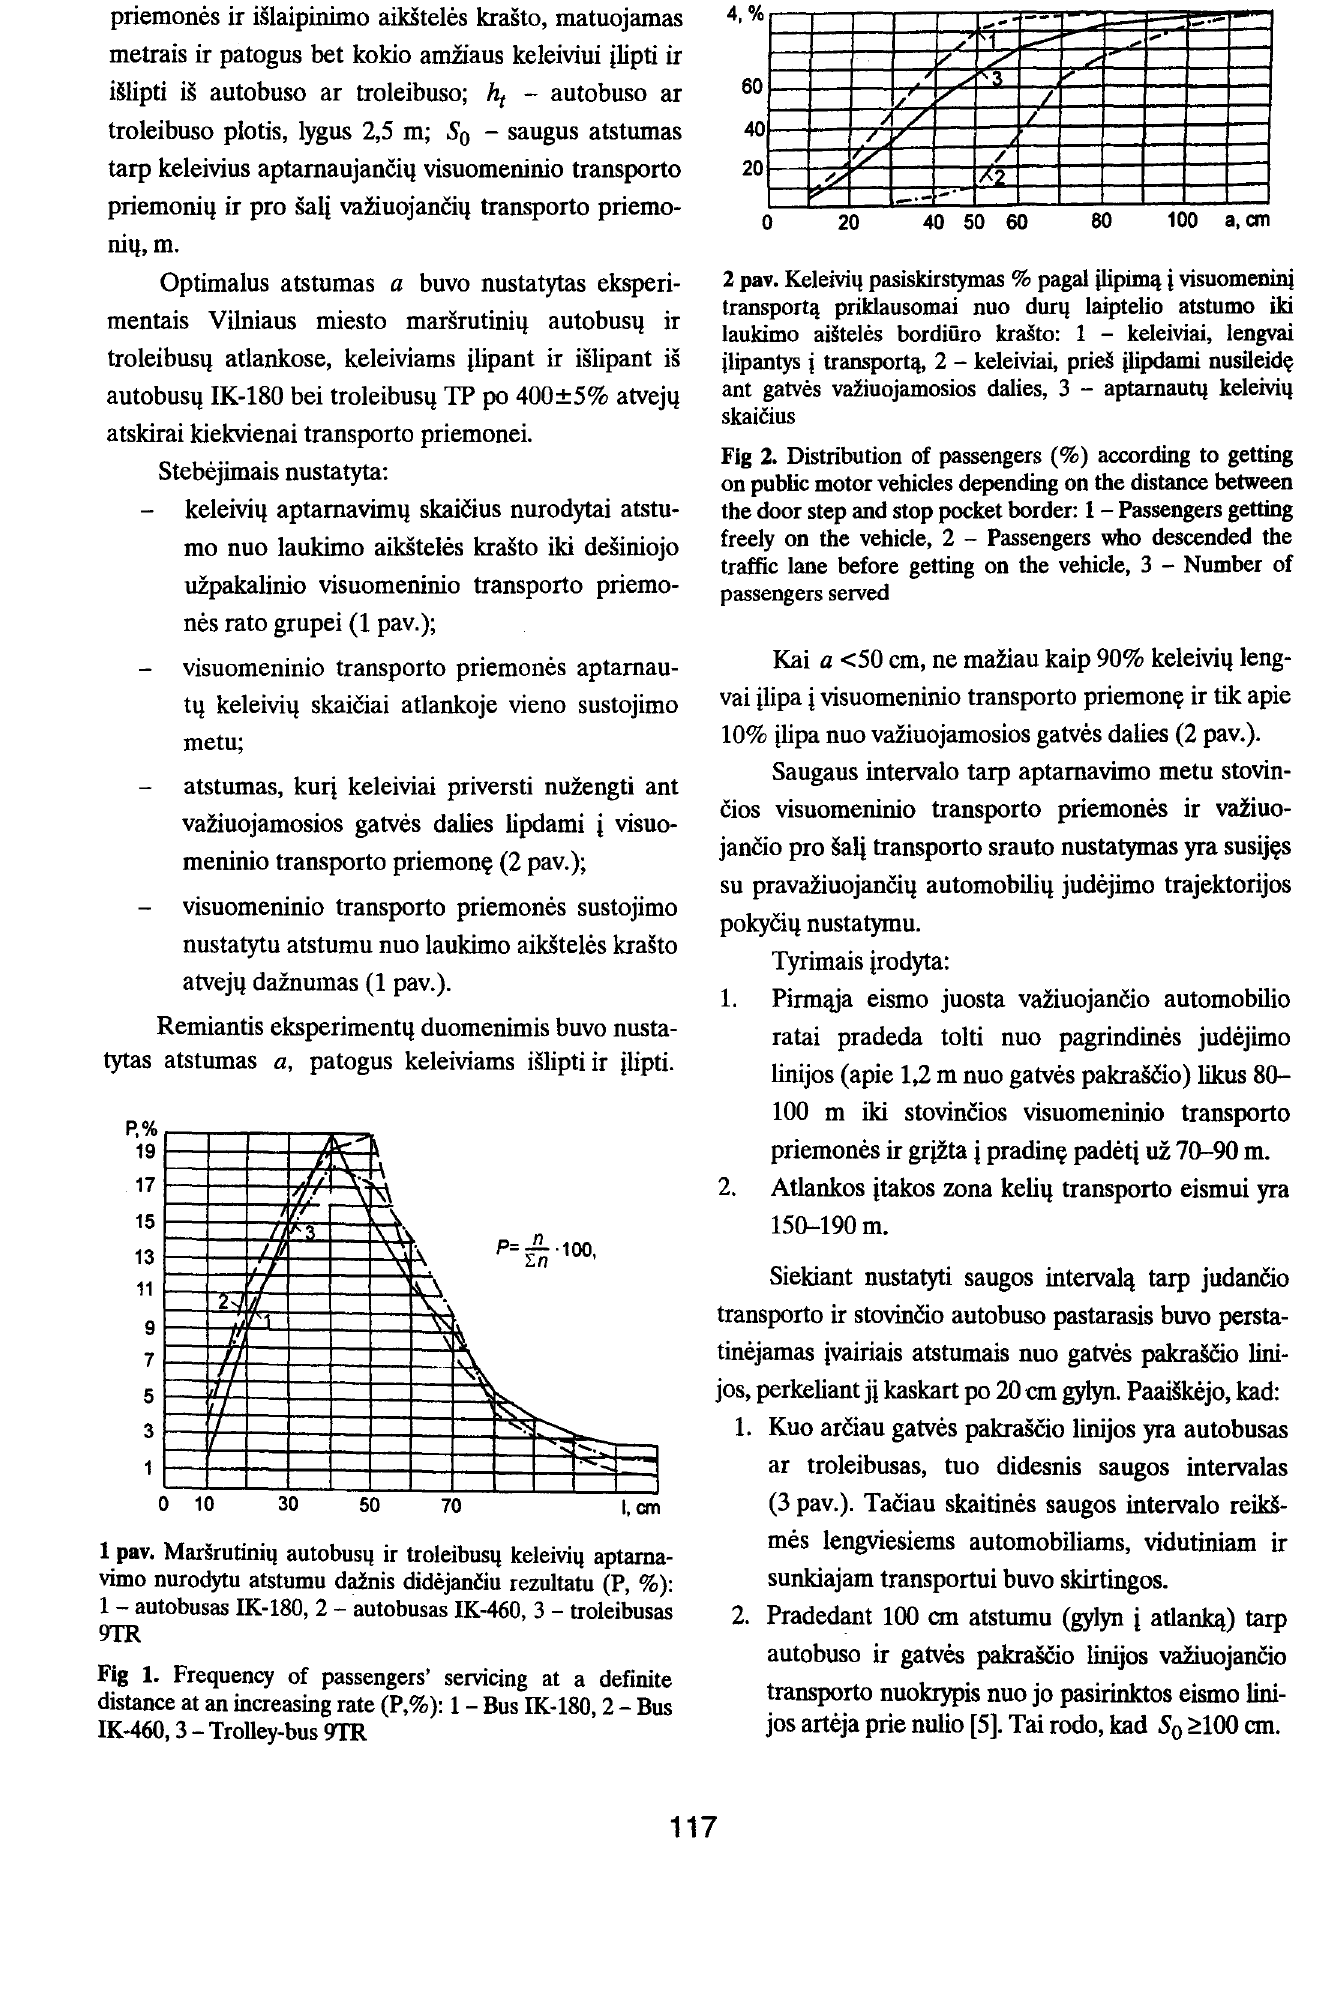
Fig 2. Distribution of passengers (%) according to getting on public motor vehicles depending on the distance between the door step and stop pocket border: 1 - Passengers getting freely on the vehicle, 2 - Passengers who descended the traffic lane before getting on the vehicle, 3 - Number of passengers